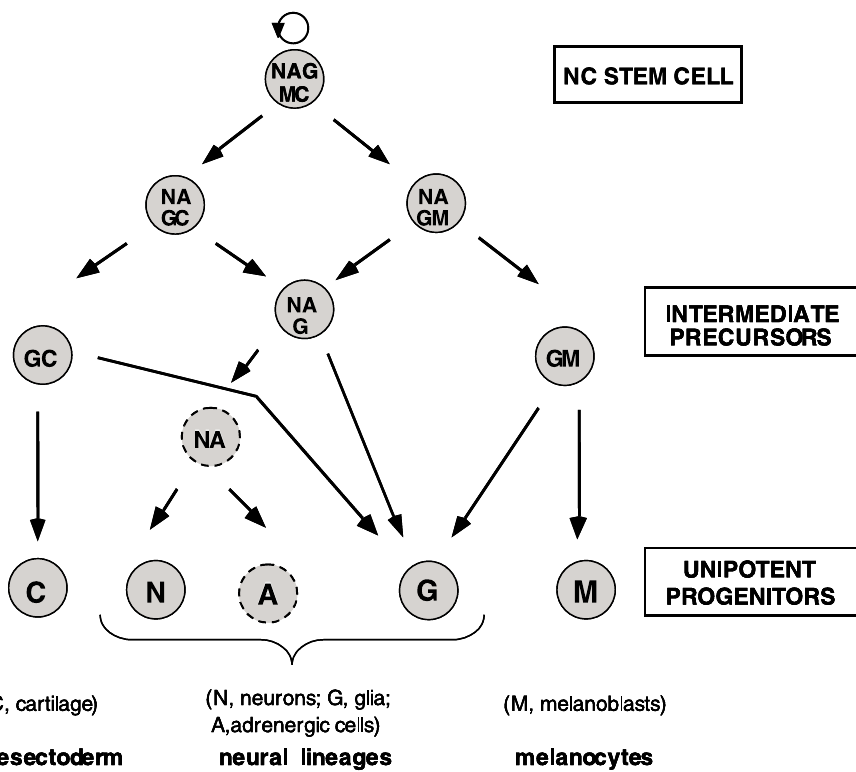
Fig. 2 – Model for the segregation of cell lineages derived from the cephalic NC. Diagram illustrating the different progenitors from quail mesencephalic NC cells grown in clonal cultures. The presence of cartilage(C),neurons(N),glialcells(G),adrenergiccells(A)andmelanocytes(M)wasrecordedinthe colonies. Progenitorshavebeenclassifiedaccordingtothenumberofthesedistinctphenotypesintheir progeny. The results are consistent with the generation of unipotent progenitors from a ‘totipotent’ stem cell through several intermediate oligopotent precursors. Filiations between precursors are only